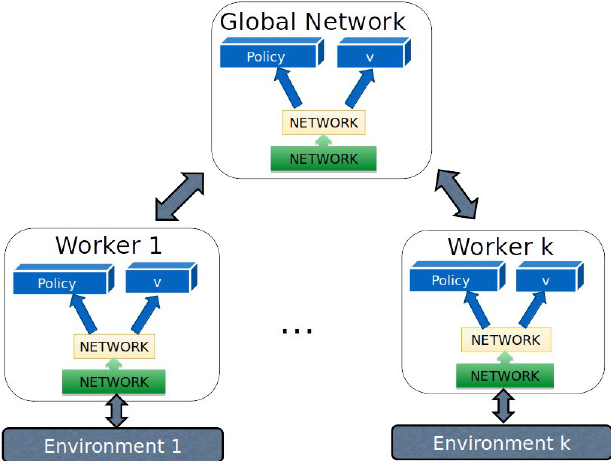
Figure 1. A3C architecture. A worker runs in its own thread or process, interacting with a copy of the environment. A separate process collects each worker’s gradients separately and applies them to a global neural network model. Although each worker has its copy of the neural network and runs in its simulation, after a finite number of time steps, the worker’s neural network is synchronized with the global neural